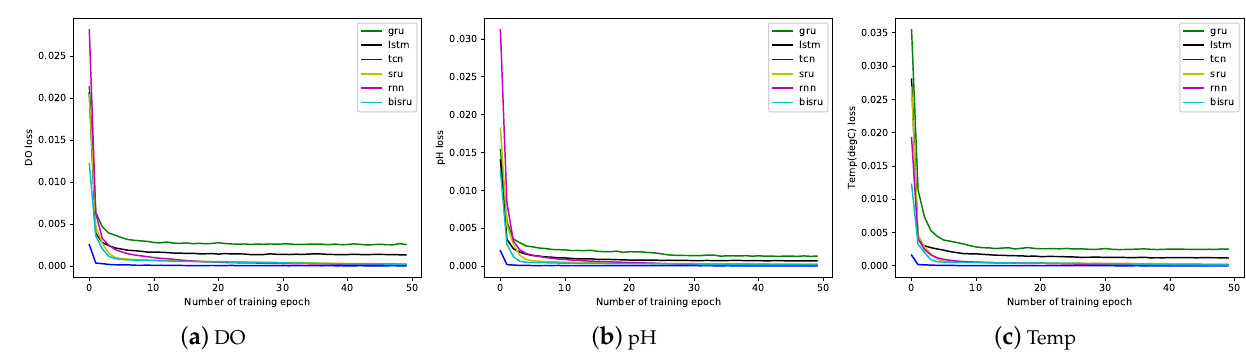
Figure 4. Comparison of changes in loss function of different models during model training: ( a ) dissolved oxygen, ( b ) pH, ( c ) water